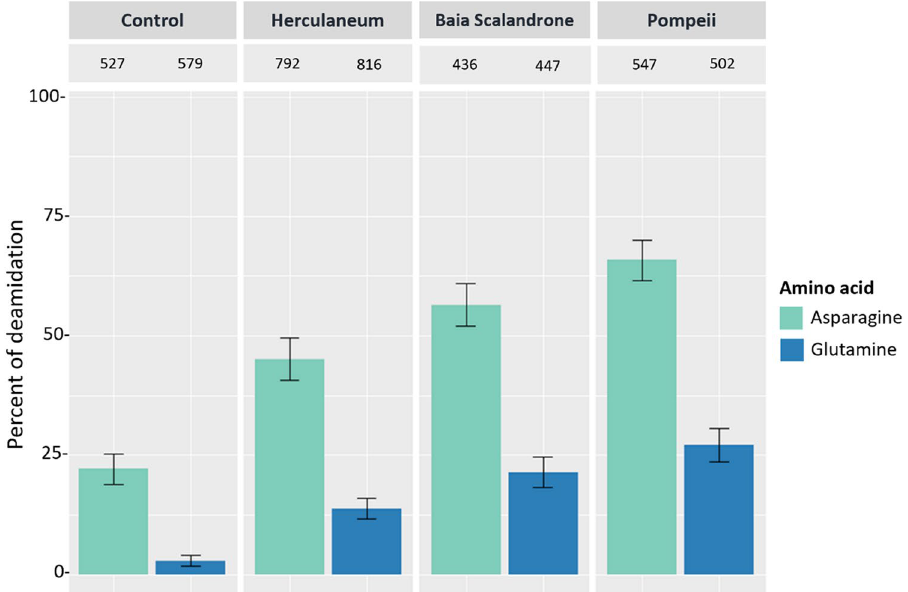
Figure 1. Overall percentage of deamidation for asparagine and glutamine residues of collagenous bone proteins from Pompeii, Herculaneum, Baia Scalandrone and control (H-162, H-142 from 34 ). Error bars represent standard deviation and numbers above each bar represent the number of deamidation sites the data is based